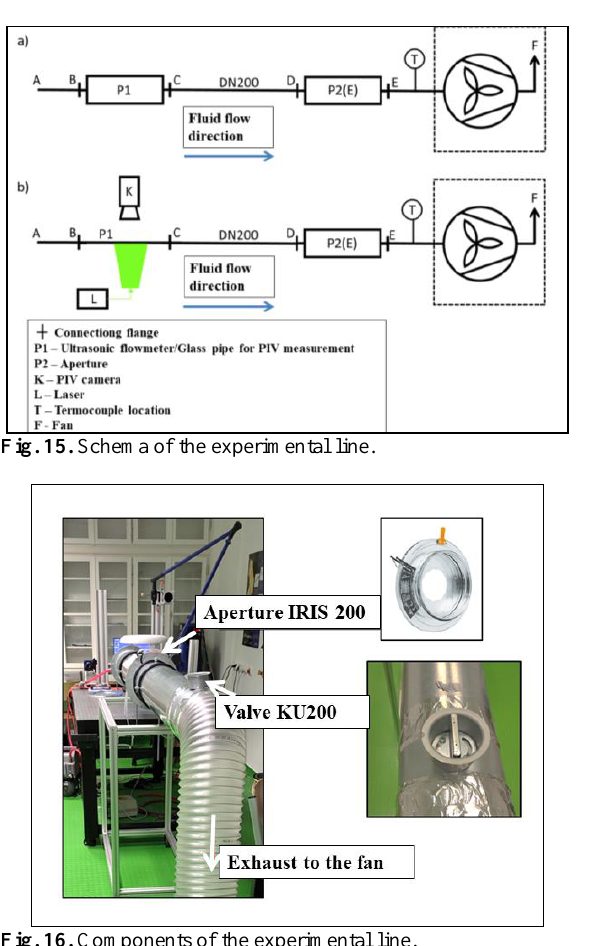
Fig. 16. Components of the experimental line.